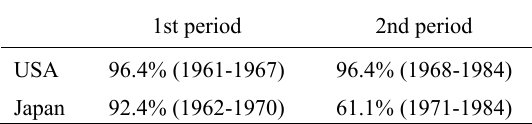
Table 1. Learning Rate of Color TV Figure 3. Experience Curve by TV Type in